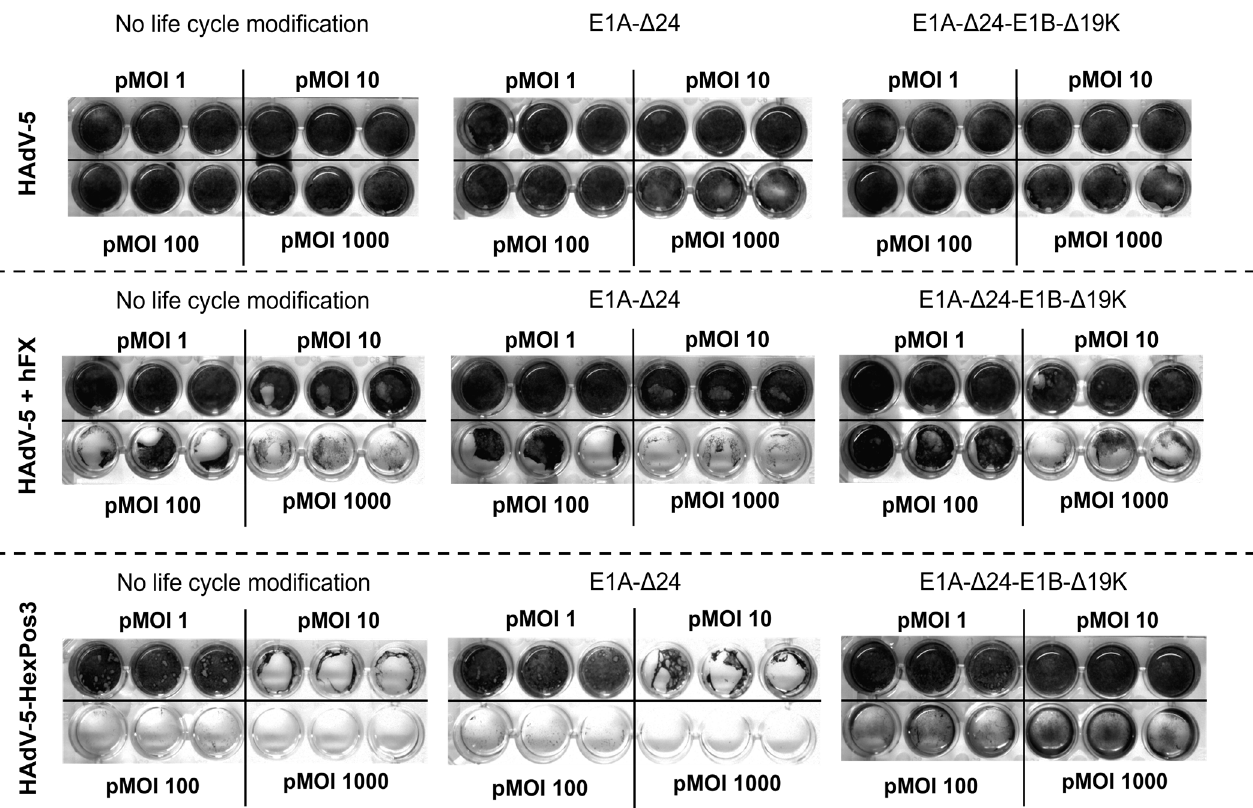
Figure 1. Replication-competent HAdV-5 carrying the HexPos3 mutation shows improved lysis of hMSCs. Human MSCs were infected with the indicated replicating virus (±human Factor X (hFX) as transduction enhancer) and indicated pMOIs. Six days post-infection, the wells were washed with PBS to remove all detached cells. Subsequently, remaining cells were fixed with 4% PFA and stained with crystal violet. After three more washing steps, plates were air-dried. The experiment was performed with BM- and A-hMSCs of three healthy donors. Representative images of one BM-hMSCs donor are shown.